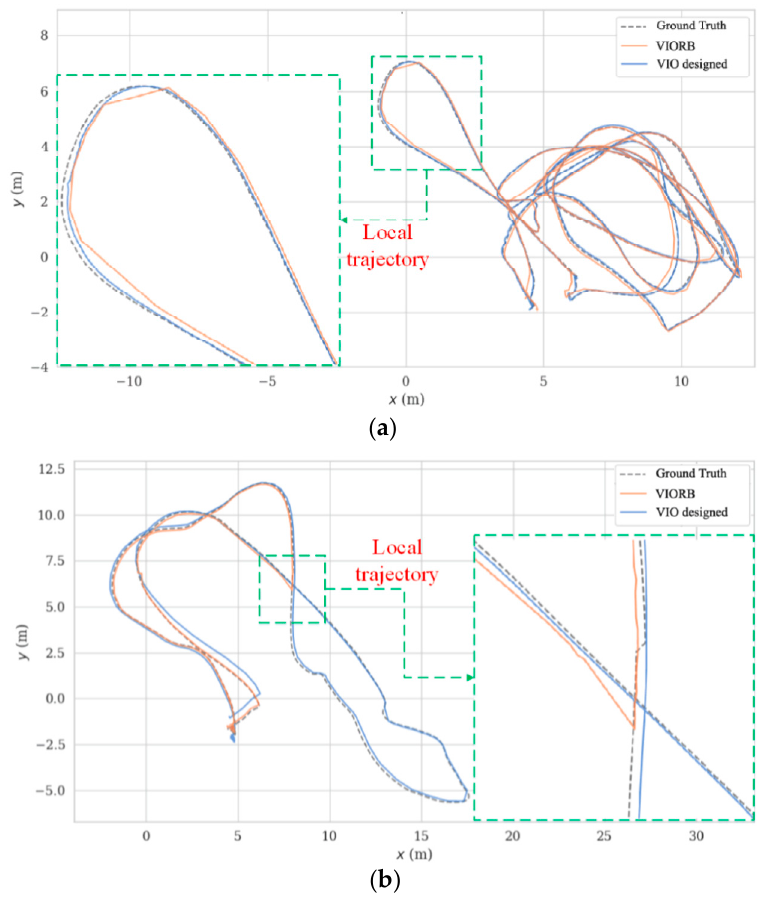
Figure 8. VIO planar trajectory comparisons, ( a ) V1_01_easy sequence; ( b ) MH_04_difficult sequence.